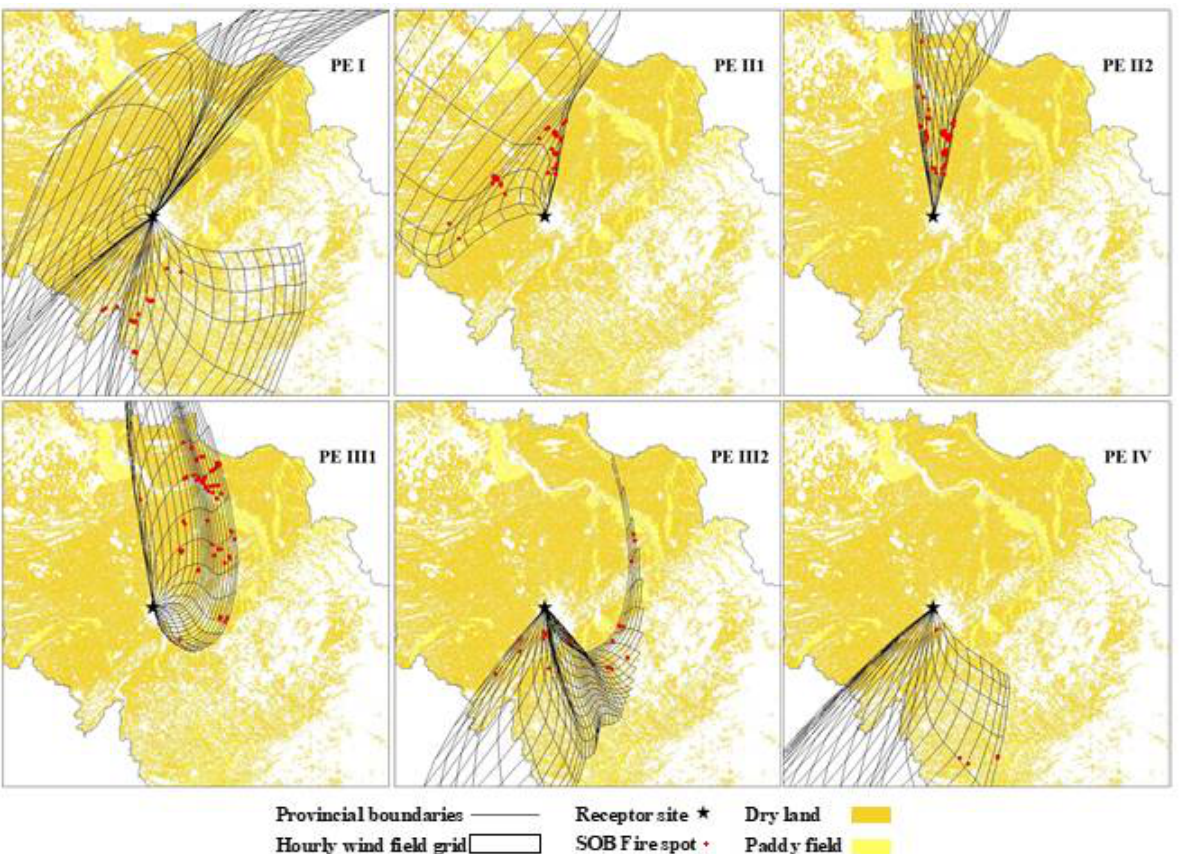
Figure 8. Spatial distribution of hourly transport pathways and hourly wind-field grids during each PE and the identified straw open burning fire spots. Note: to avoid spatial overlap, HWFGs of PE II are divided and shown in two panels of PE II1 and PE II2, whose arrival times are from 17:00 to 23:00 on April 7, and from 23:00 on April 7 to 8:00 on April 8, respectively. Analogously, HWFGs of PE III are divided and shown in two panels of PE III 1 and PE III 2, whose arrival times are from 13:00 on April 8 to 7:00 on April 9, and from 7:00 on April 9 to 11:00 on April 10, respectively.